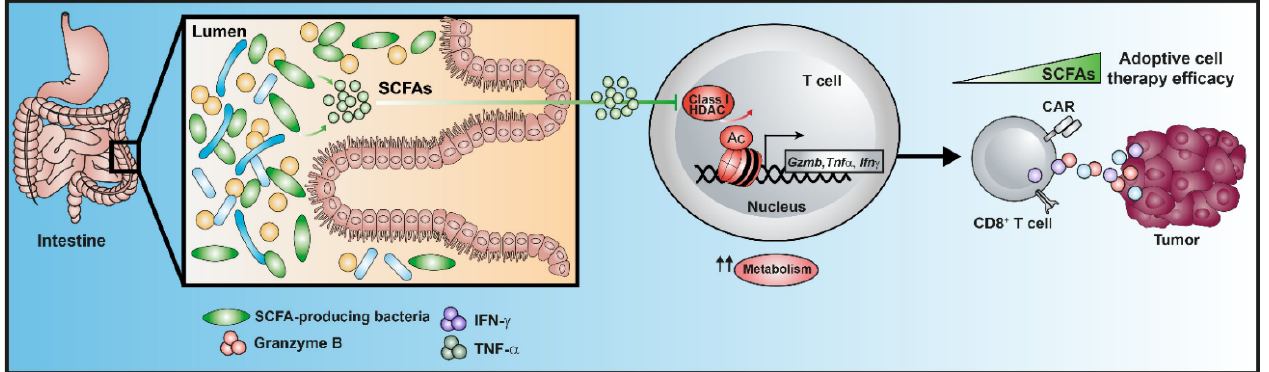
Figure 1. Schematic overview of the molecular mechanisms underlying modulation of T cell func- tion and phenotype by SCFAs. The SCFAs butyrate and valerate seem to be good candidates for augmenting the efficacy of cellular immunotherapy for cancer. These microbial metabolites enhance the effector cytokine production and functionality of CD8 + T cells by fine-tuning their metabolic and epigenetic signatures. Abbreviations: short-chain fatty acids (SCFAs); chimeric antigen receptor (CAR); granzyme B (Gzmb); tumor necrosis factor ( TNF); interferon (IFN).